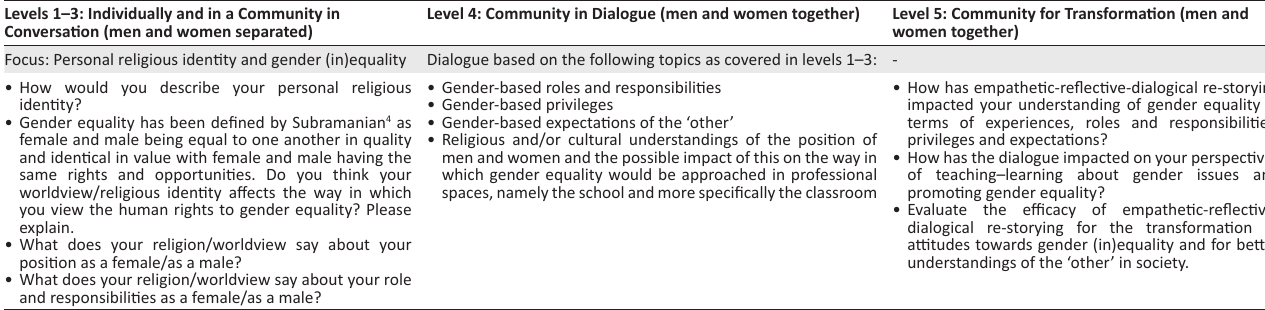
TABLE 1: Questions informing the focus on religious identity and gender equality. 39 Levels 1–3: Individually and in a Community in Level 4: Community in Dialogue (men and women together) Level 5: Community for Transformation (men and Conversation (men and women separated)